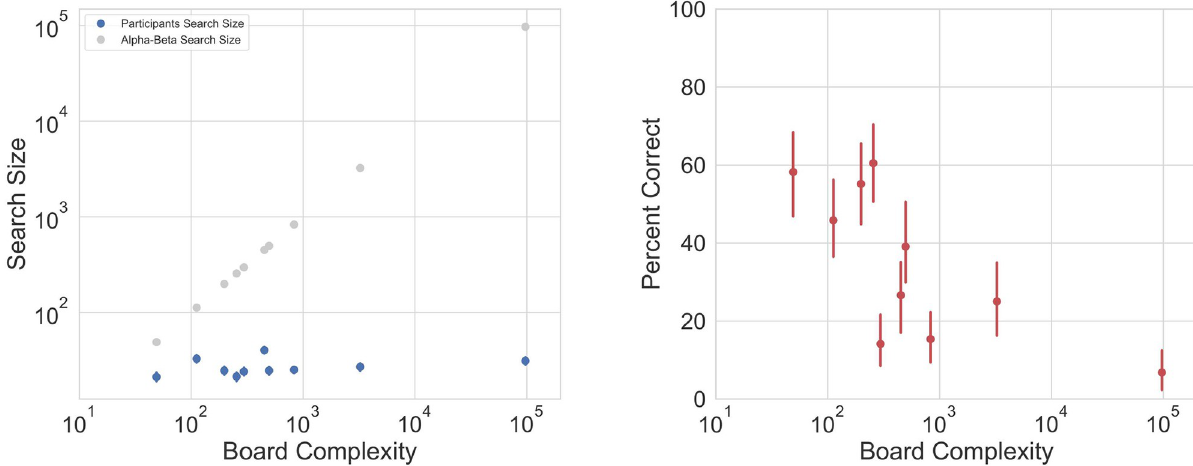
Fig 2. Participants search size does not depend on the board’s complexity. A) Participants’ search size (blue) is small and fixed compared with the search size of alpha-beta pruning (gray). B) The percent of participants who solved correctly each of the board configurations, by board complexity. As board complexity increases, participants’ success rate decreases, yet at a slower rate compared to the board’s complexity increase. Error bars depict 95% confidence